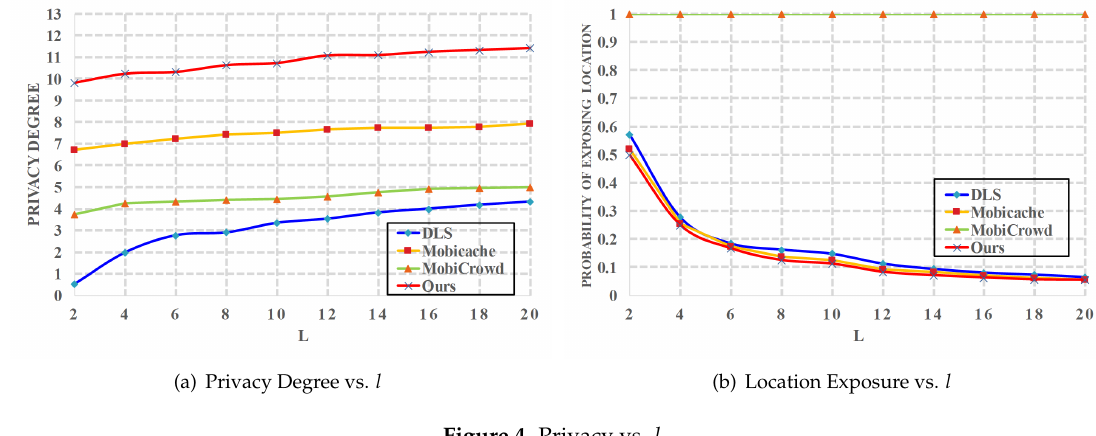
Figure 4. Privacy vs. l